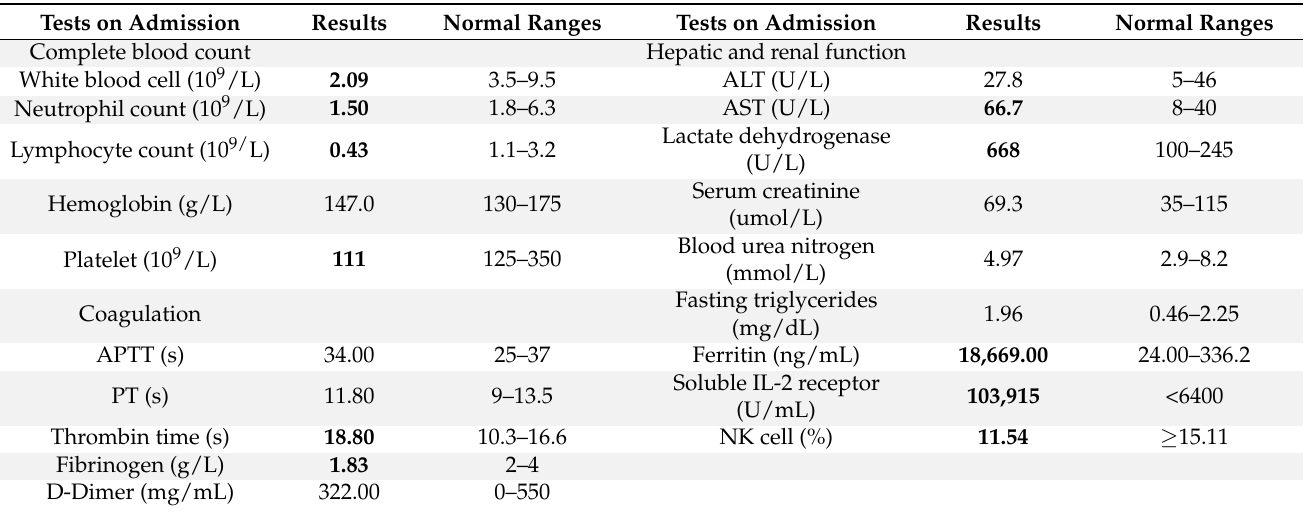
Figure 2. Generalized pruritic annular to irregular erythema, accompanied by edema on the left side of the face. Table 1. Laboratory tests on the second admission.